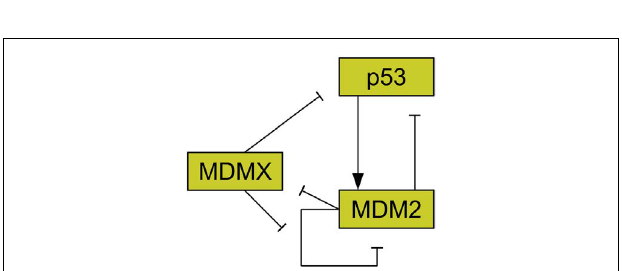
FIGURE 2 | Relationships between MDMX, MDM2, and p53. MDM2 inhibits p53 and is promoted by it. MDM2 inhibits itself and this effect is reduced by MDMX. MDMX inhibits p53 directly, and is itself inhibited by MDM2.